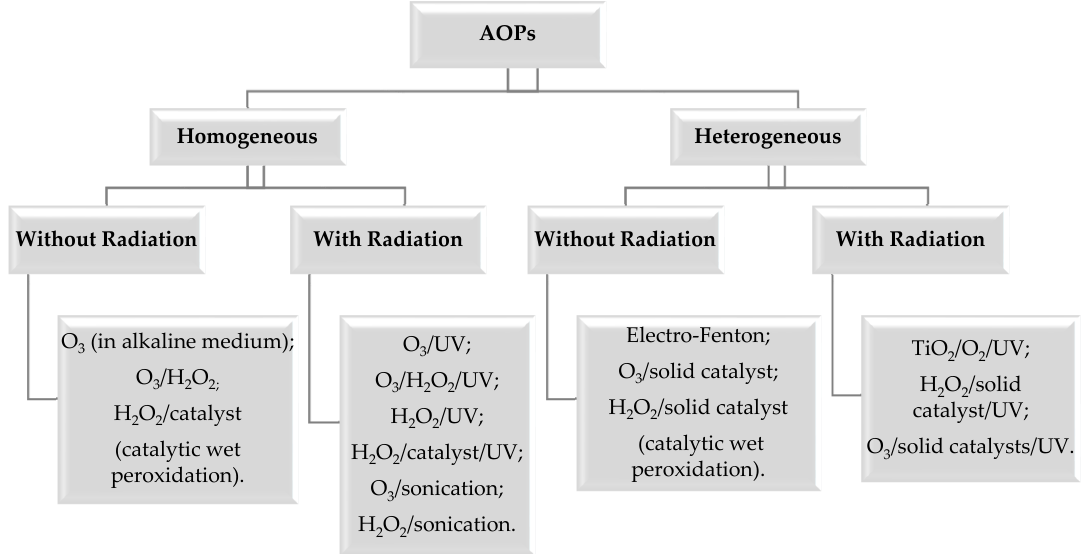
Figure 1. Some relevant advanced oxidation processes (AOPs) for wastewater treatment (adapted from Poyatos et al. [24]).